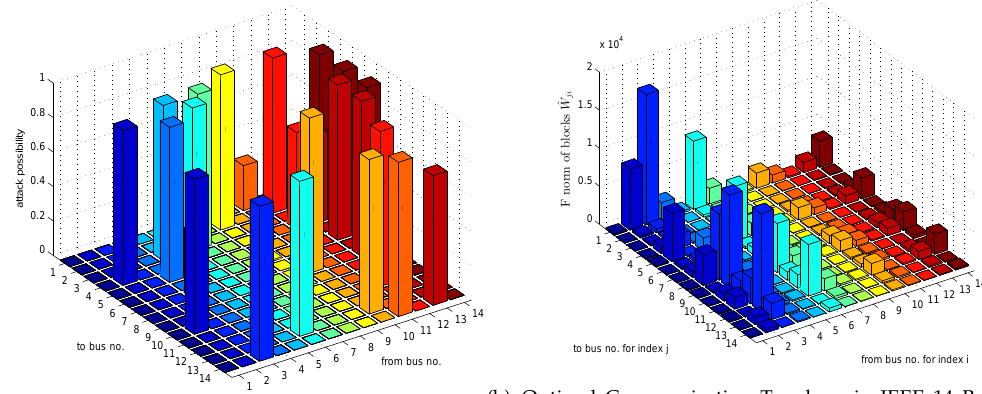
Figure 5. Optimal DoS attacks and control structure 3D Graph in the IEEE 14 bus